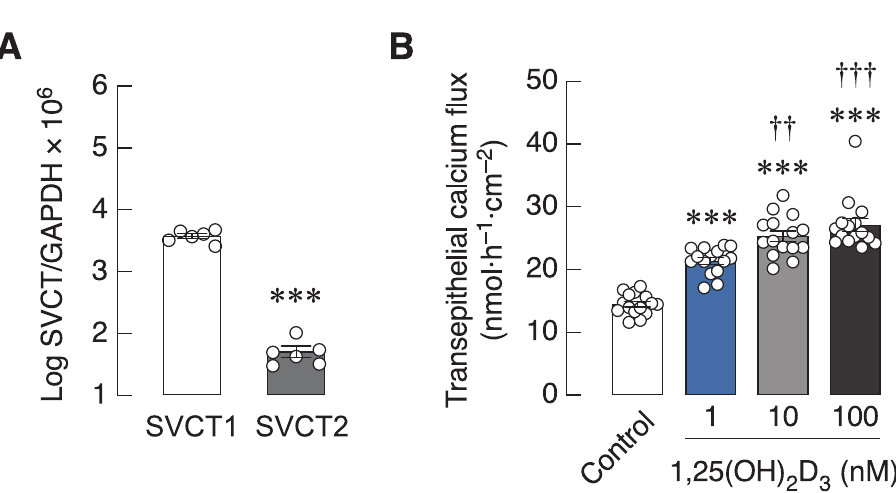
Fig 1. mRNA expression of vitamin C transporters and 1,25(OH) 2 D 3 -induced calcium transport in Caco-2 monolayer. Expression of sodium-vitamin C co-transporters (SVCT and SVCT2) in Caco-2 cells (A). GAPDH is a housekeeping gene for normalization. (n = 6; ��� , P < 0.001 compared with the SVCT1 group. (B) Transepithelial calcium flux across the 1,25(OH) 2 D 3 -treated Caco-2 monolayers in Ussing chamber in the absence of transepithelial calcium gradient. ��� P < 0.001 compared with the control group (white bar); †† P < 0.01; ††† P < 0.001 compared with the 1 nM 1,25(OH) 2 D 3 -treated group (blue